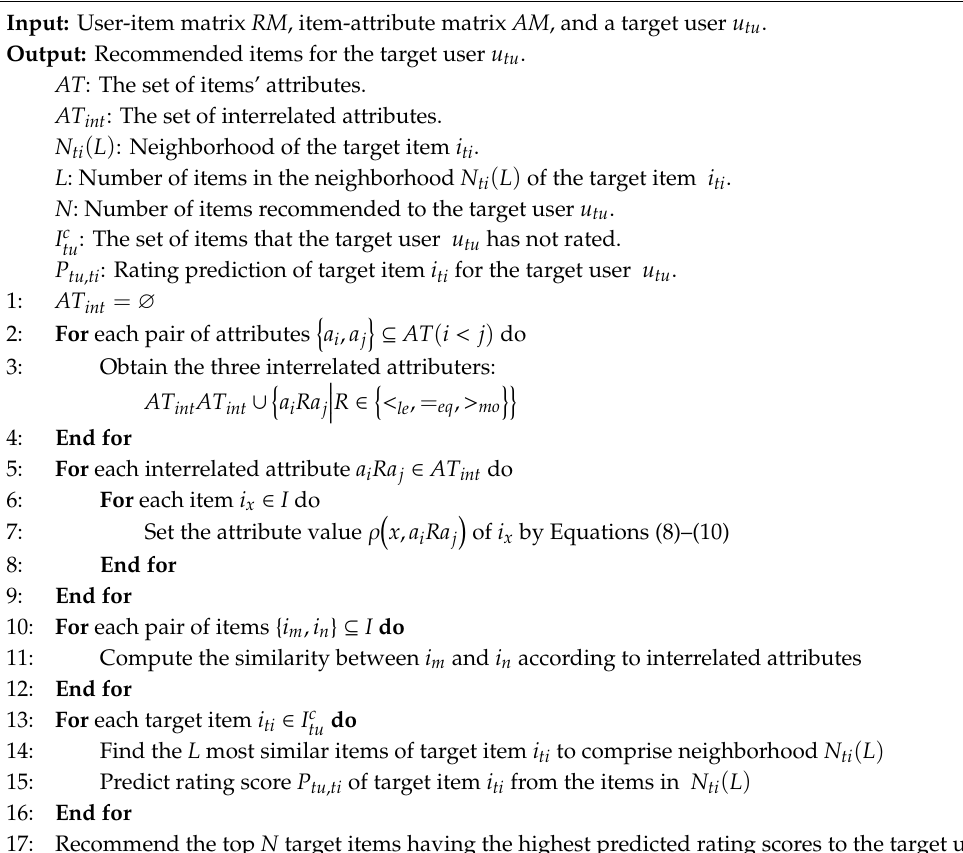
Algorithm 1 Proposed